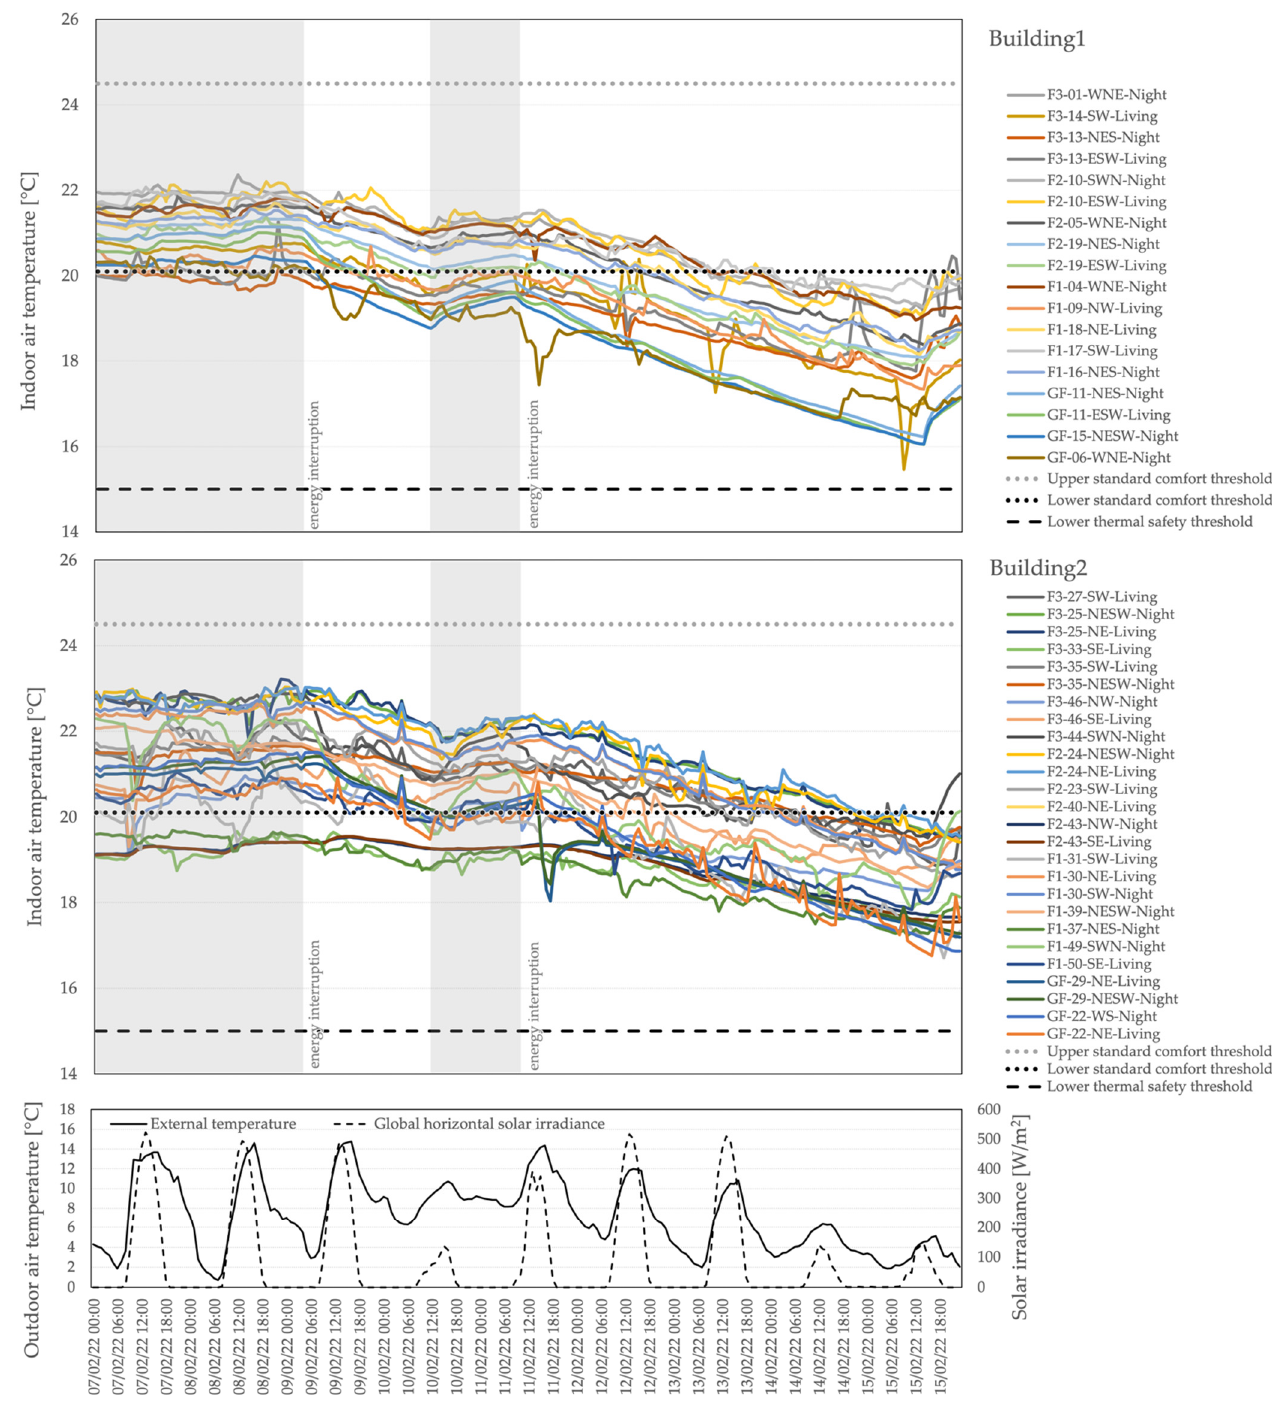
Figure 12. Measured indoor air temperature in Building 1 ( upper image ) and Building 2 ( lower image ) from 7 to 15 February 2022.